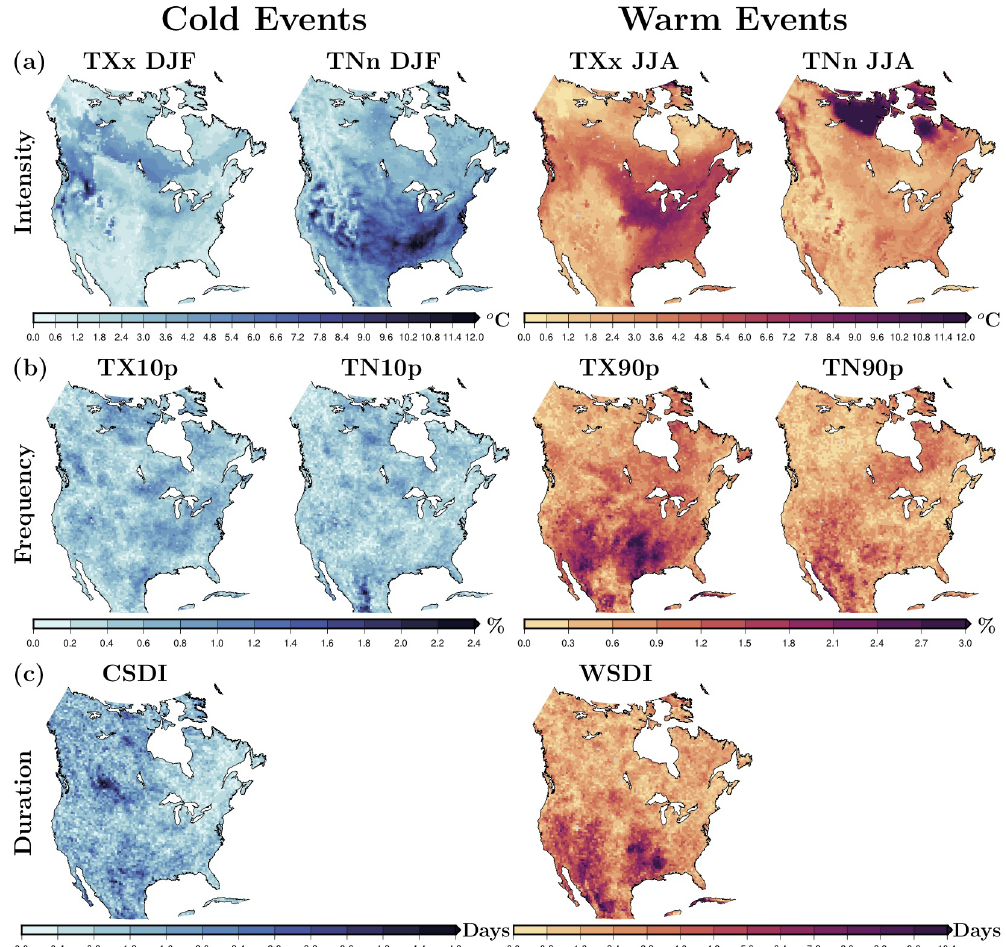
Figure 5. Multi-model ranges across the WRF simulations (i.e., difference between the highest value and the lowest value of the four WRF simulations at each grid cell) of extreme indices associated with the intensity (a) , frequency (b) and duration (c) of cold (left) and warm (right) extreme temperature events (TXx/TNn, maximum/minimum value of the maximum/minimum daily temperatures; TN10p/TX10p, percentage of cold nights/days; TN90p/TX90p, percentage of hot nights/days; CSDI/WSDI, cold/warm spell duration index). The range among simulations is computed using the mean of each index from 1980 to 2012 for each